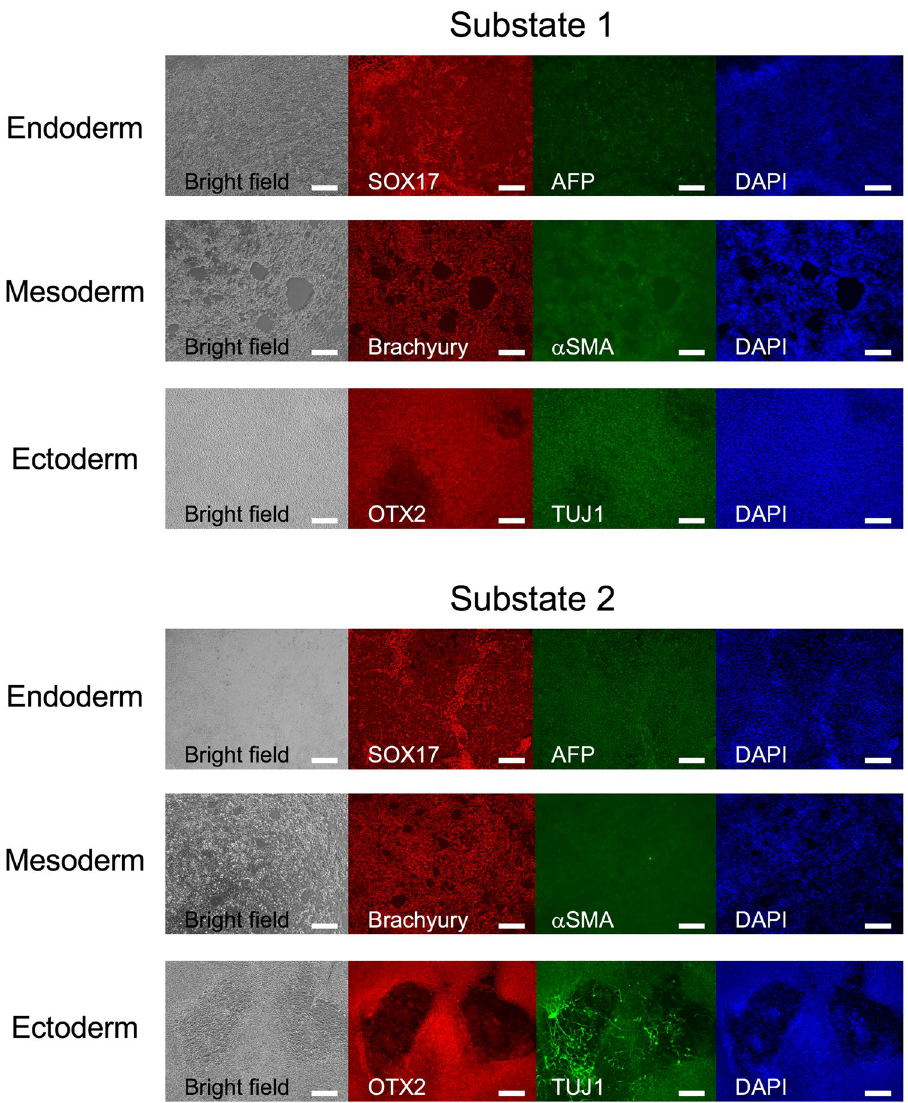
Figure 4. Immunohistochemical analysis of three germ layer markers in substate 1 and substate 2 of H9 cells. Immunohistochemistry with permeabilisation using antibodies for endoderm (SOX17 and AFP), mesoderm (brachyury and α SMA), and ectoderm (OTX2 and TUJ1) markers. Nuclei were counterstained with DAPI. The scale bar represents 200 µ